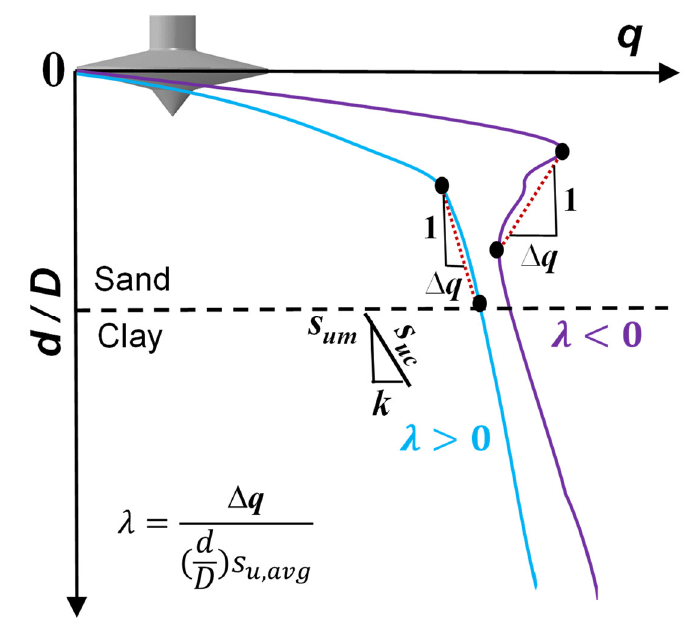
Figure 7. Definition of degree of post-peak reduction λ.